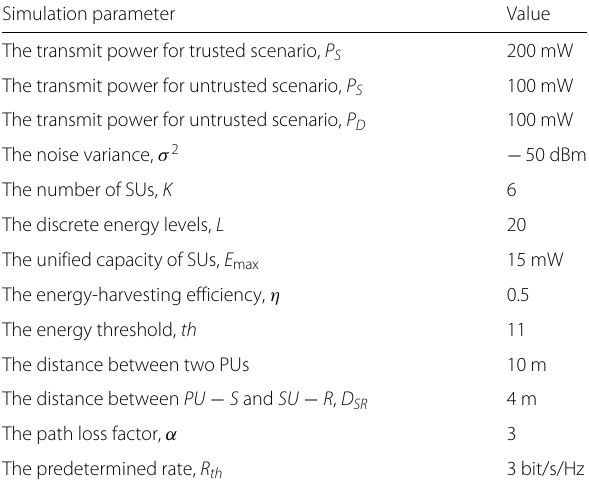
stable as the energy discrete levels L increases. And the outage probability will increase as the predetermined rate R th increases. When the given rate reaches 7 bit/s/Hz, the system outage is too high to